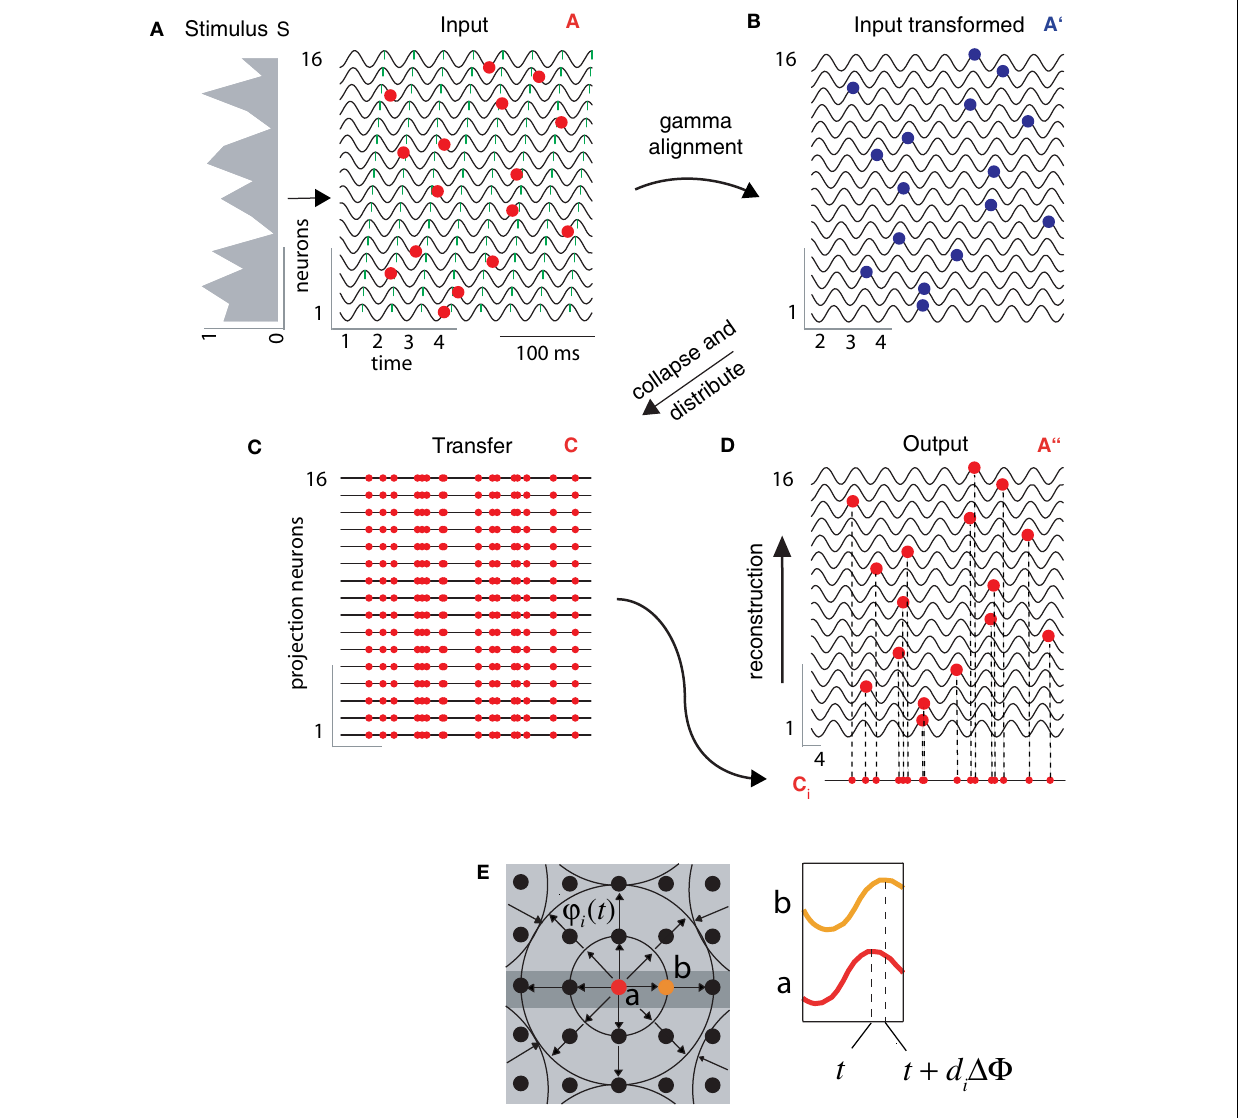
FIGURE 2 | Stages of information encoding, transfer, and reconstruction illustrated on a 16-neuron simulation. (A) INPUT: Neurons at the input layer convert the stimulus, represented by an analog intensity vector (left), to a latency vector where the delay of AP (red markers) is inversely proportional to the intensity of input. Oscillations in adjacent neurons are phase shifted by a constant 0.1 π relative to each other (green ticks mark oscillation peaks). (B) GAMMA ALIGNMENT: AP generation is most likely when the input pattern coincides with the maxima of the ongoing SMO (blue markers). Time is shifted one period at each stage. (C) TRANSFER: All APs from all neurons are collapsed into a single sequence of APs, and this sequence is distributed over an array of projection neurons (red markers). (D) OUTPUT: When one of the AP sequences is transferred to the target layer, it provides the same input to each neuron